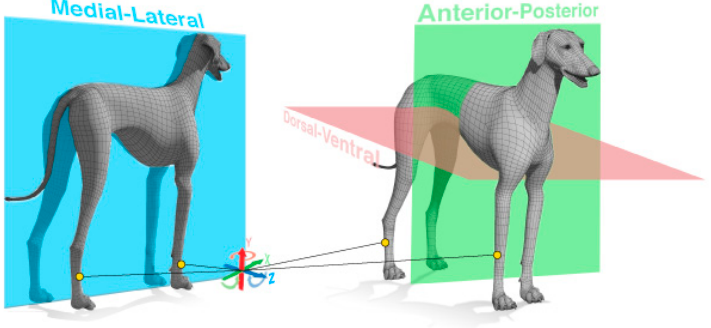
Figure 3. Cartesian to animal centric coordinate system (Anterior = A, Posterior = P, Dorsal = D, Ventral = V, Medial = M, Lateral = L). Direction of the arrow discerns positive axis. End mapping was +X = AP, +Y = DV, +Z = ML). Sensors were placed laterally on each leg such that the medial-lateral axis were